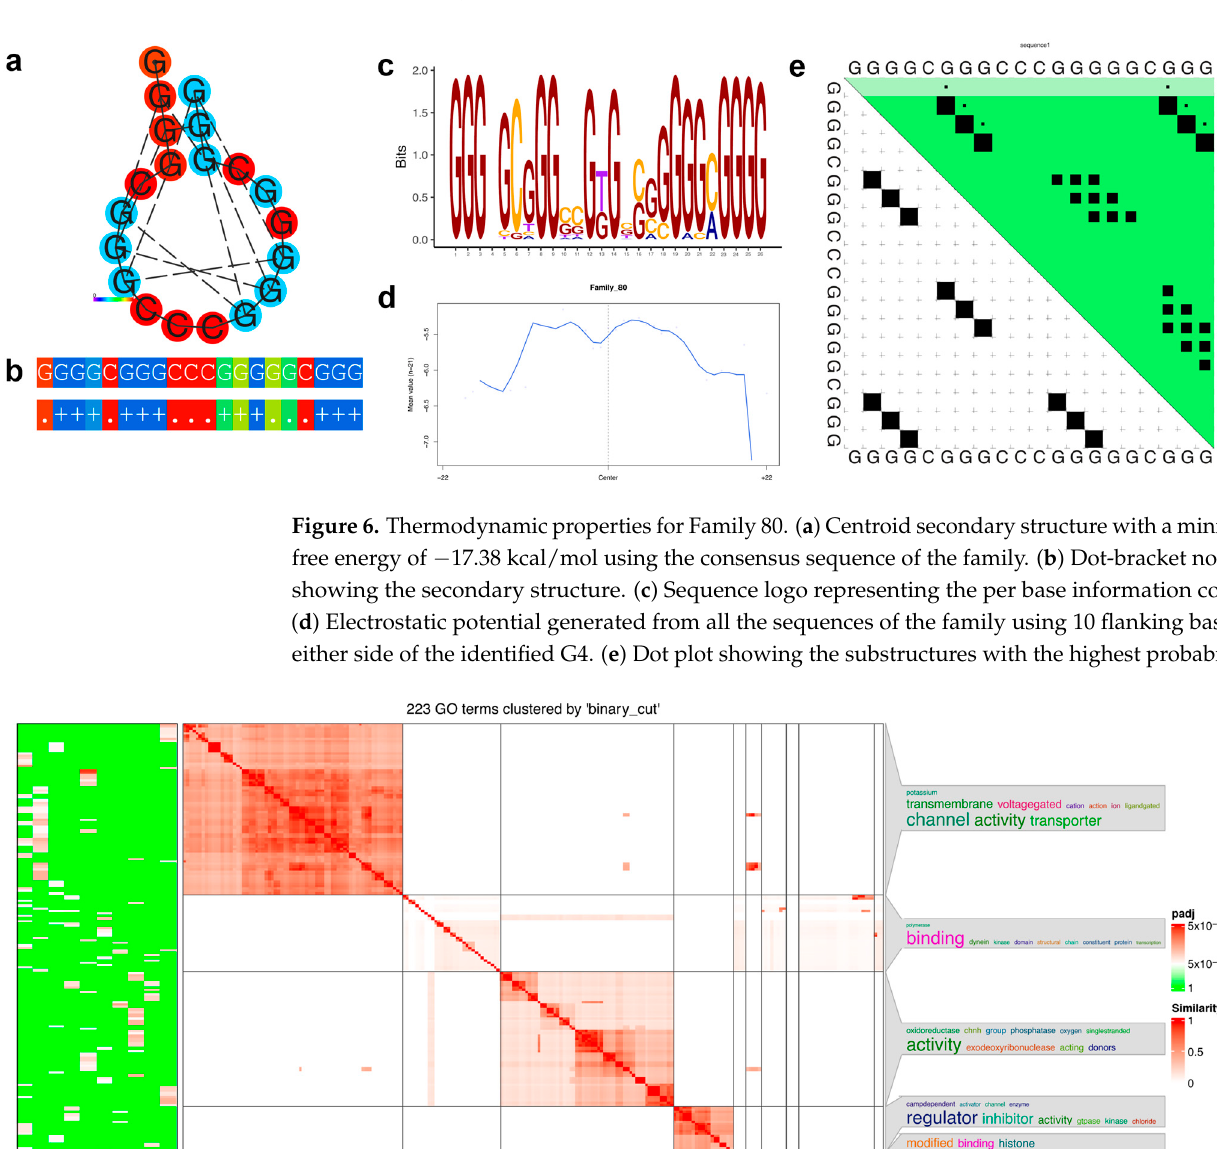
Figure 5. Thermodynamic properties for Family 75. ( a ) Centroid secondary structure with a mini- mum free energy of -22.82 kcal/mol using the consensus sequence of the family. ( b ) Dot-bracket notation showing the secondary structure. ( c ) Sequence logo representing the per base information content. ( d ) Electrostatic potential generated from all the sequences of the family using 10 flanking bases on either side of the identified G4. ( e ) Dot plot showing the substructures with the highest probabilities.